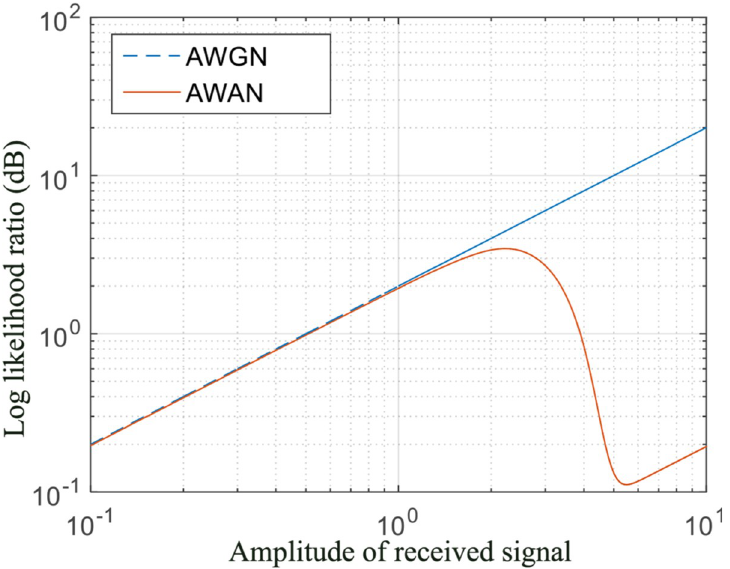
Fig 4. LLR for AWGN and AWAN